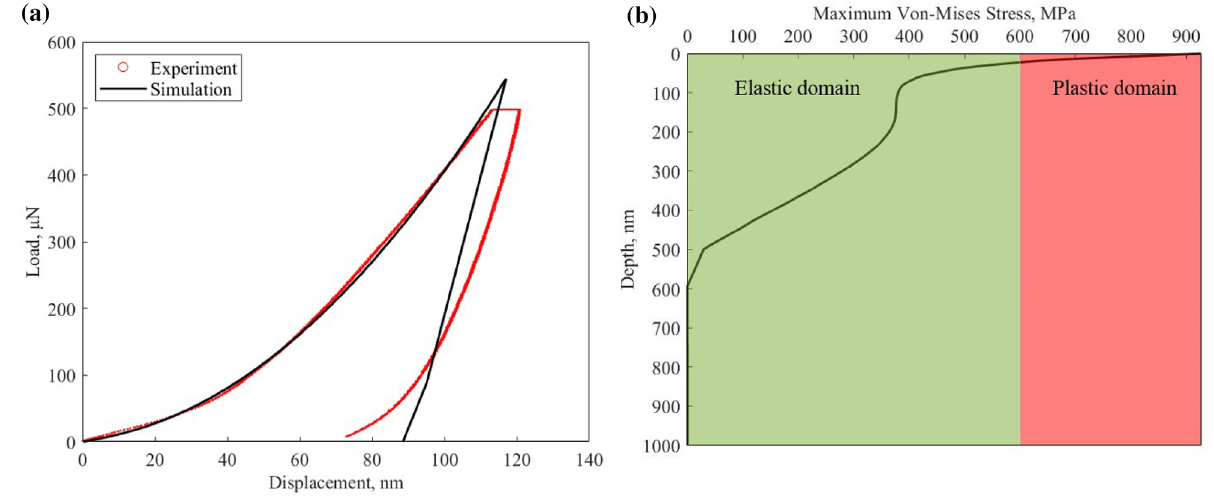
Figure 6. ( a ) Comparison of experimental and numerical load and displacement curve. ( b ) The Von-Mises stress changes depending on the indentation depth during the numerical